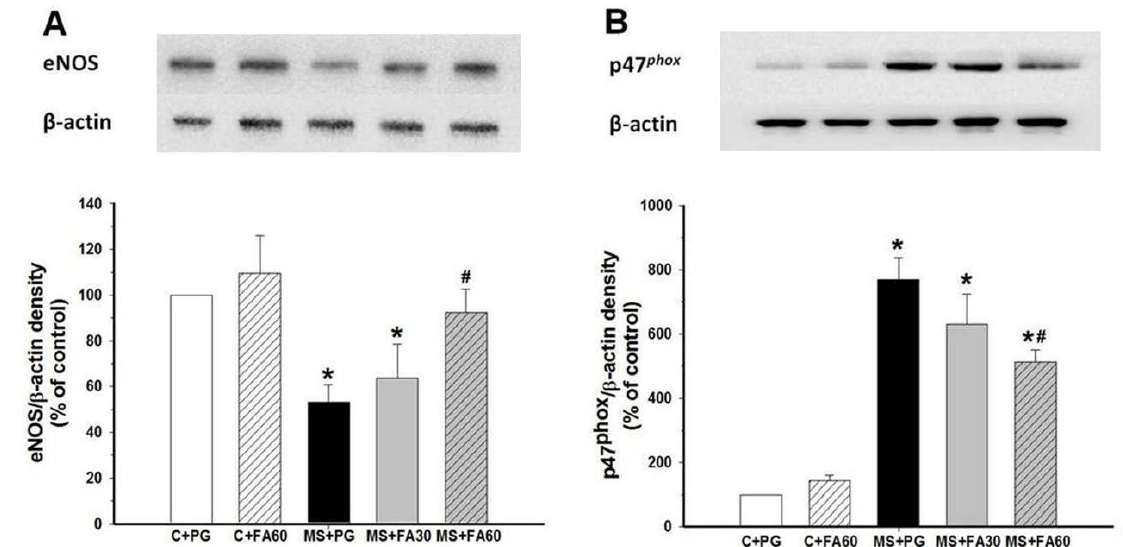
Figure 7. Effect of FA on eNOS protein (A) and p47 phox protein (B) expression in aortas of MS rats. Data are presented as a percentage of normal controls values and expressed as mean ± standard error of the mean (SEM). Data obtained from at least five different experiments. * p < 0.05 vs. C + PG, # p < 0.05 vs. MS group. FA, ferulic acid; eNOS, endothelial nitric